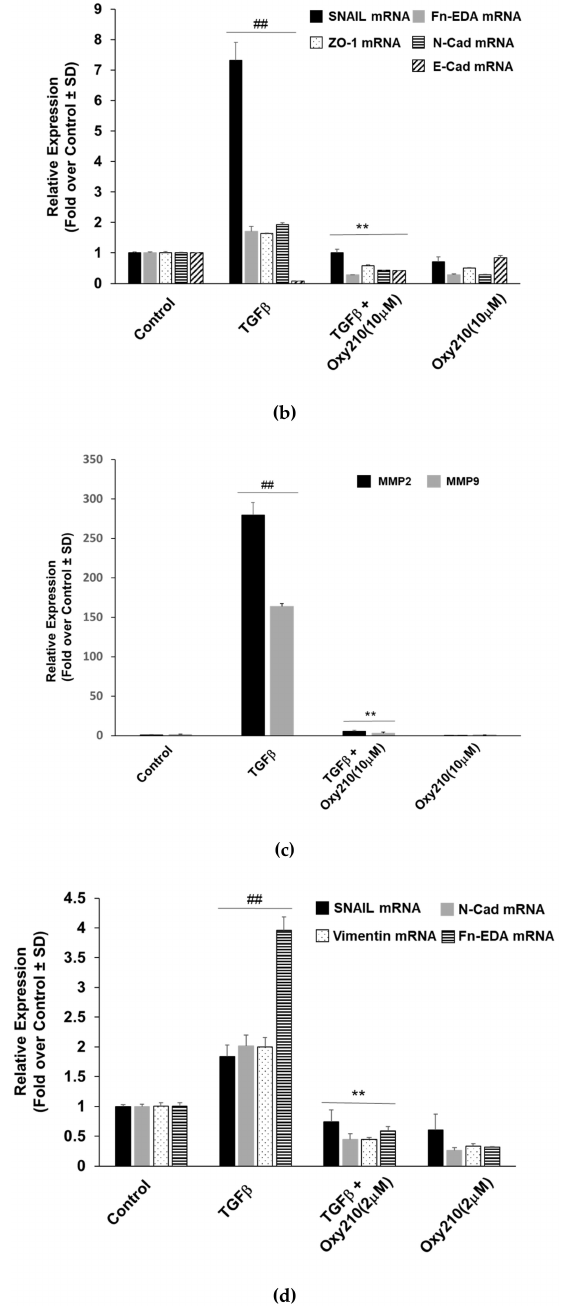
Figure 8. Inhibition of TGF β -induced EMT in NSCLC cells. ( a ) A549 cells were treated with TGF β in the absence or presence of Oxy210 in RPMI 1640 containing 2% FBS for 5 days. The cells were washed with PBS and then fixed with 2% formaldehyde in PBS at room temperature for 15 min. Formaldehyde was then removed, cells washed with PBS and stained with 4% Trypan Blue for 5 min. Phase contrast images were obtained using a 20X objective lens. A549 ( b , c ) and H2030 ( d ) cells were treated in RPMI 1640 containing 0.1% FBS overnight and then pretreated for 2 h with Oxy210 in RPMI 1640 containing 0.1% FBS. Next, cells were treated with TGF β in the absence or presence of Oxy210. After 48 h, RNA was extracted and analyzed by Q-RT-PCR for the expression of the genes as indicated and normalized to GAPDH expression. Data from a representative experiment are reported as the mean of triplicate determinations ± SD (** p < 0.01 vs. TGF β treated cells; ## p < 0.01 vs.